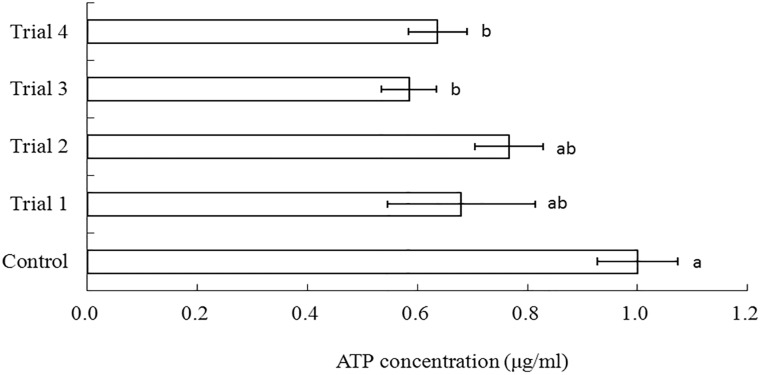
Normalized ATP concentrations of Junceella juncea oocytes after vitrification in PG-based VS2 for 2 min.Error bars represent standard errors. The bars with different letters are significantly different (P < 0.05). Trial 1: PG-based ES1 for 15mins, PG-based ES2 for 10mins; Trial 2: PG-based ES1 for 15 mins, PG-based ES2 for 5 mins; Trial 3: PG-based ES1 for 10mins, PG-based ES2 for 10mins; Trial 4: PG-based ES1 for 10mins, PG-based ES2 for 5mins.